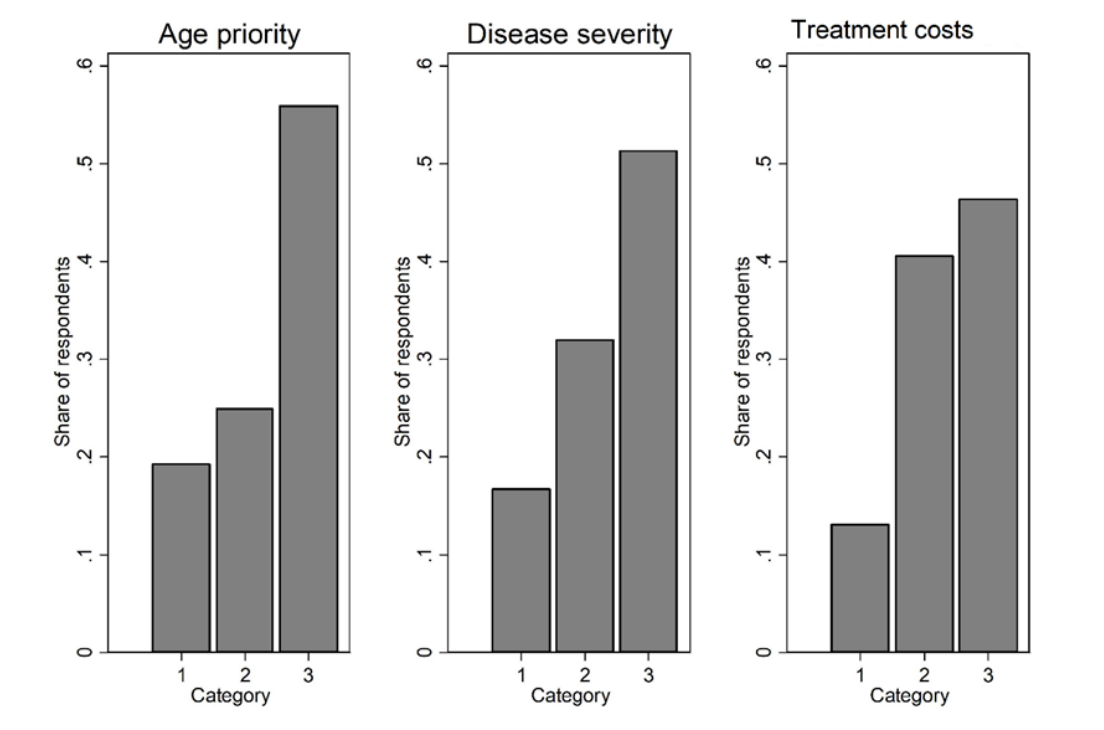
Figure 1: Distribution of answers to the prioritizing